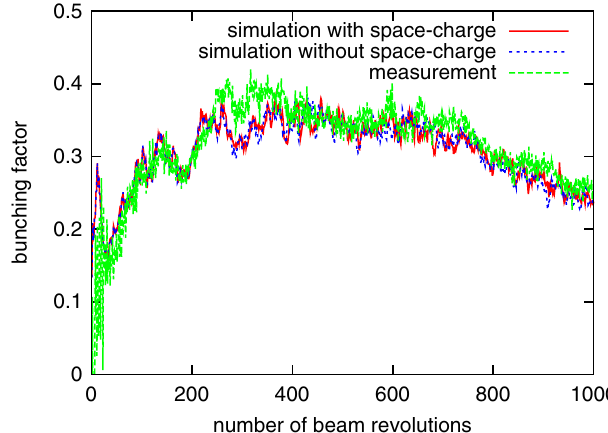
FIG. 14. (Color) Comparison between the simulation with/with- out space-charge effects and measurement, with 80% second harmonic, momentum offset of (cid:1) 0 : 2% , and phase sweep of 80 degrees.